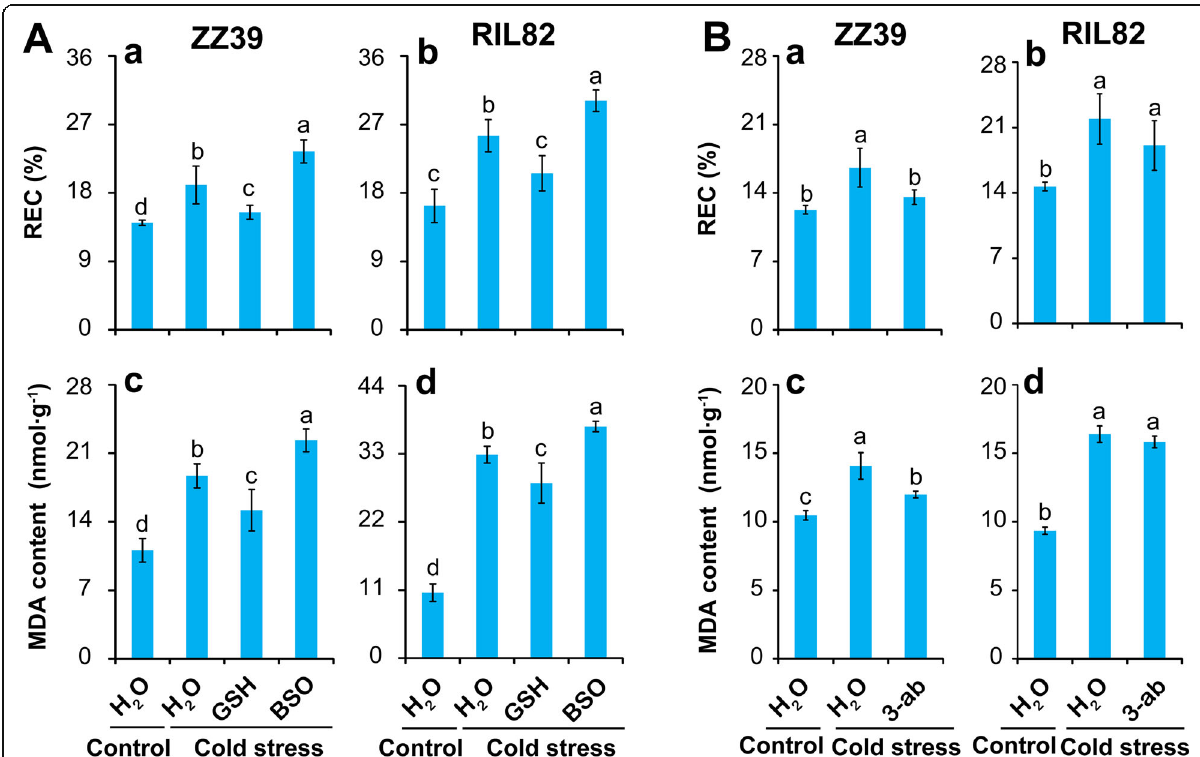
Fig. 8 Effect of GSH, BSO, or 3-ab on the contents of REC and MDA in rice leaves under cold stress. GSH, Glutathione; BSO, Buthionine sulfoximine; 3-ab, 3-aminobenzamide; REC, relative electric conductance. Vertical bars denote standard deviations ( n = 3). Different letters indicate significant differences among the treatments under control and cold stress within a genotype by two-way analysis of variance for two factors (temperature and treatment) ( P <